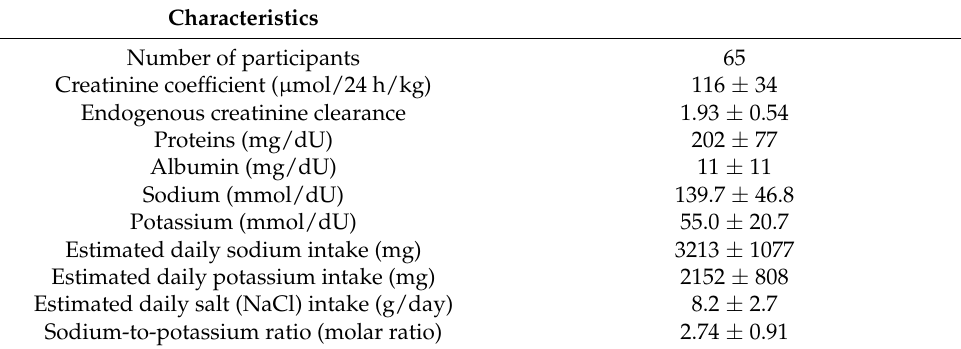
Table 3. Healthy pregnant women 24 h urine analysis.